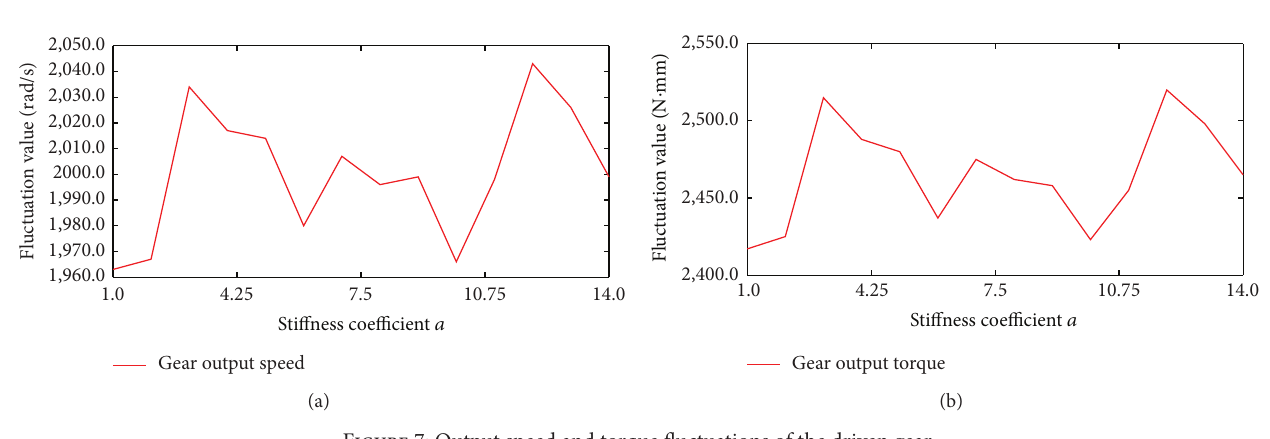
Figure 6: Output speed and torque of the drive shaft.